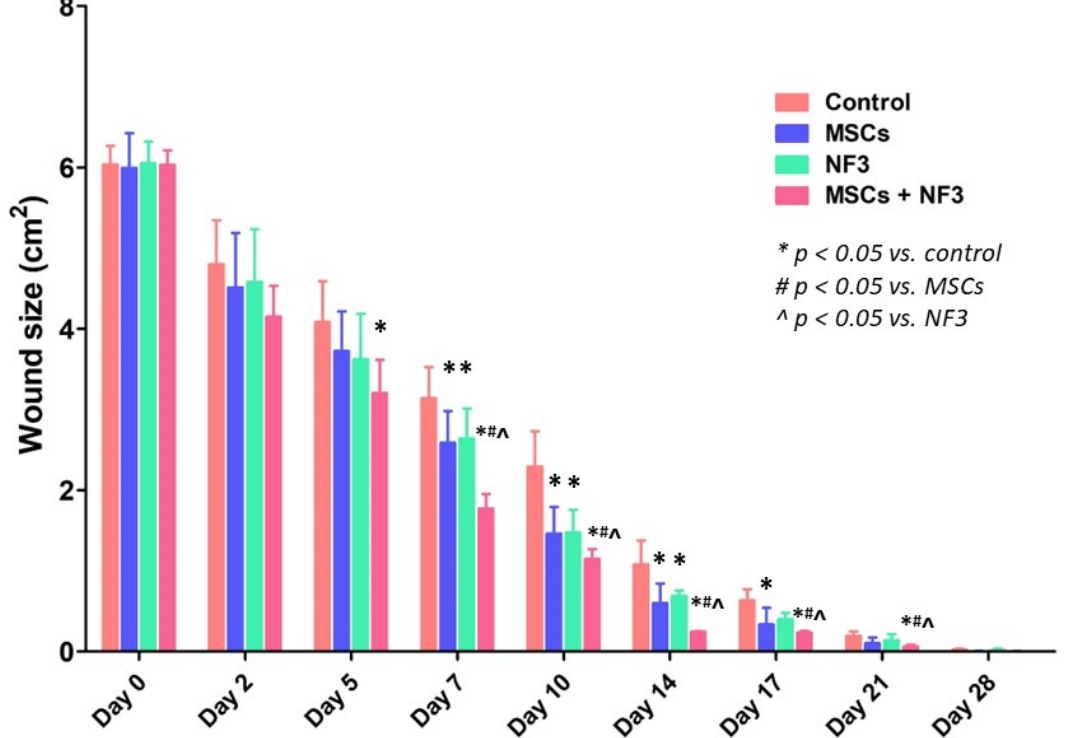
Figure 1. Wound size at different time points in each group. In the MSCs + NF3 group, the wound size presented a significant reduction from Day 5 onwards ( p < 0.05). On Day 7, 10, and 14, all treatments promoted wound healing significantly ( p < 0.05), while the combined treatment further enhanced the healing effect ( p < 0.05). On Day 17, MSCs and the combined treatment kept reducing the wound size ( p < 0.05), but no significant difference was observed in the NF3 group. The wound was closed and completely healed by Day 21 in the MSCs + NF3 group ( p < 0.05). All wounds had completely healed by Day 28.